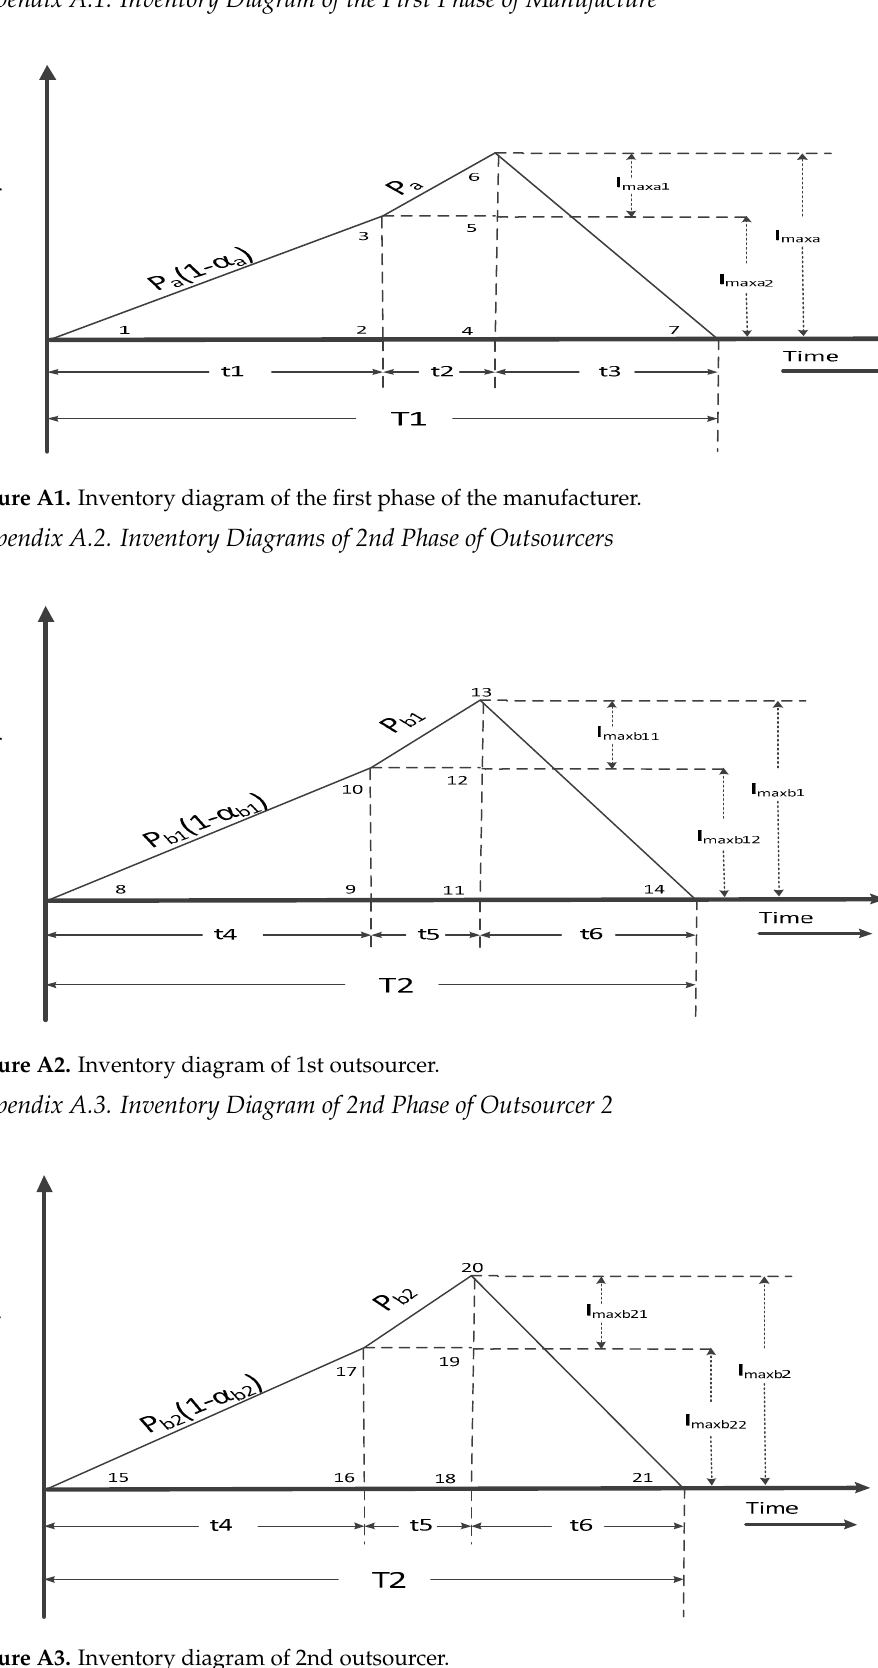
Figure A3. Inventory diagram of 2nd outsourcer .